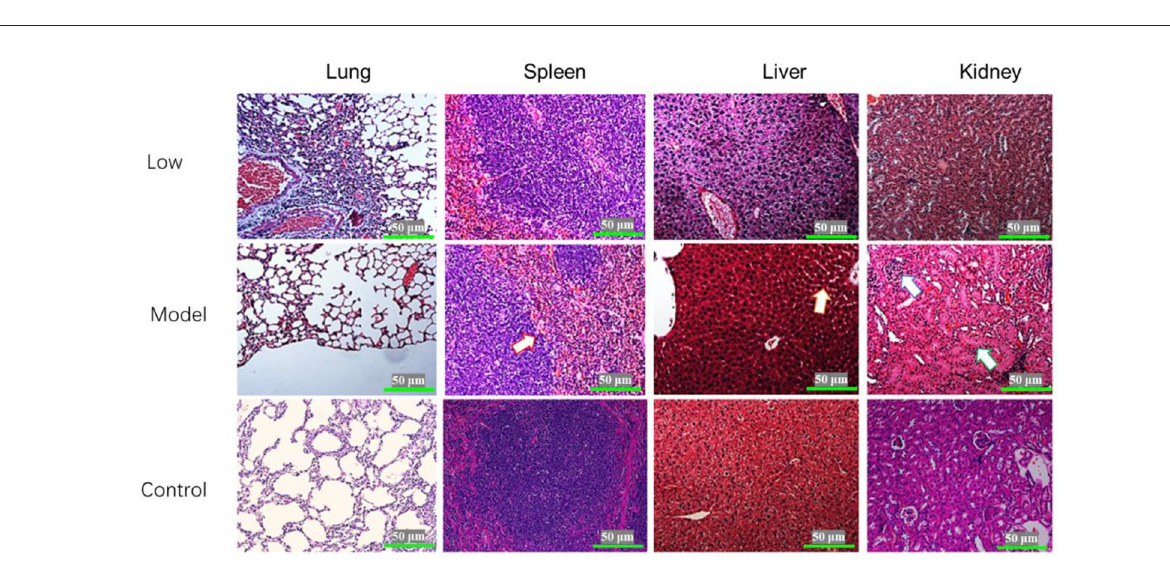
FIGURE5 Histopathological examination of the lungs, spleen, liver, and kidneys of piglets infected with SVV (HE × 400). The arrow on Model-spleen indicated the hemorrhage diffuse; the arrow on Model-liver indicated the cell swelling; and the arrows on Model-kidney indicated the glomerular atrophy and tubular